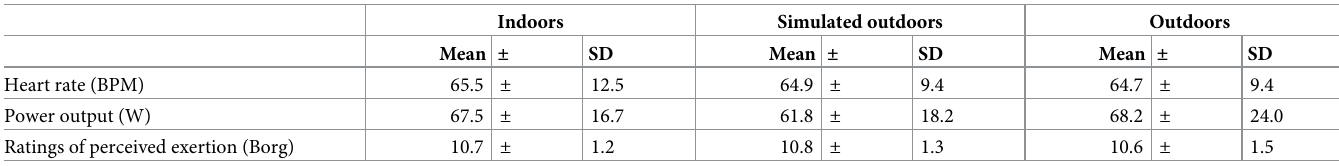
Table 2. Mean baseline values across the three environments. Indoors Simulated outdoors